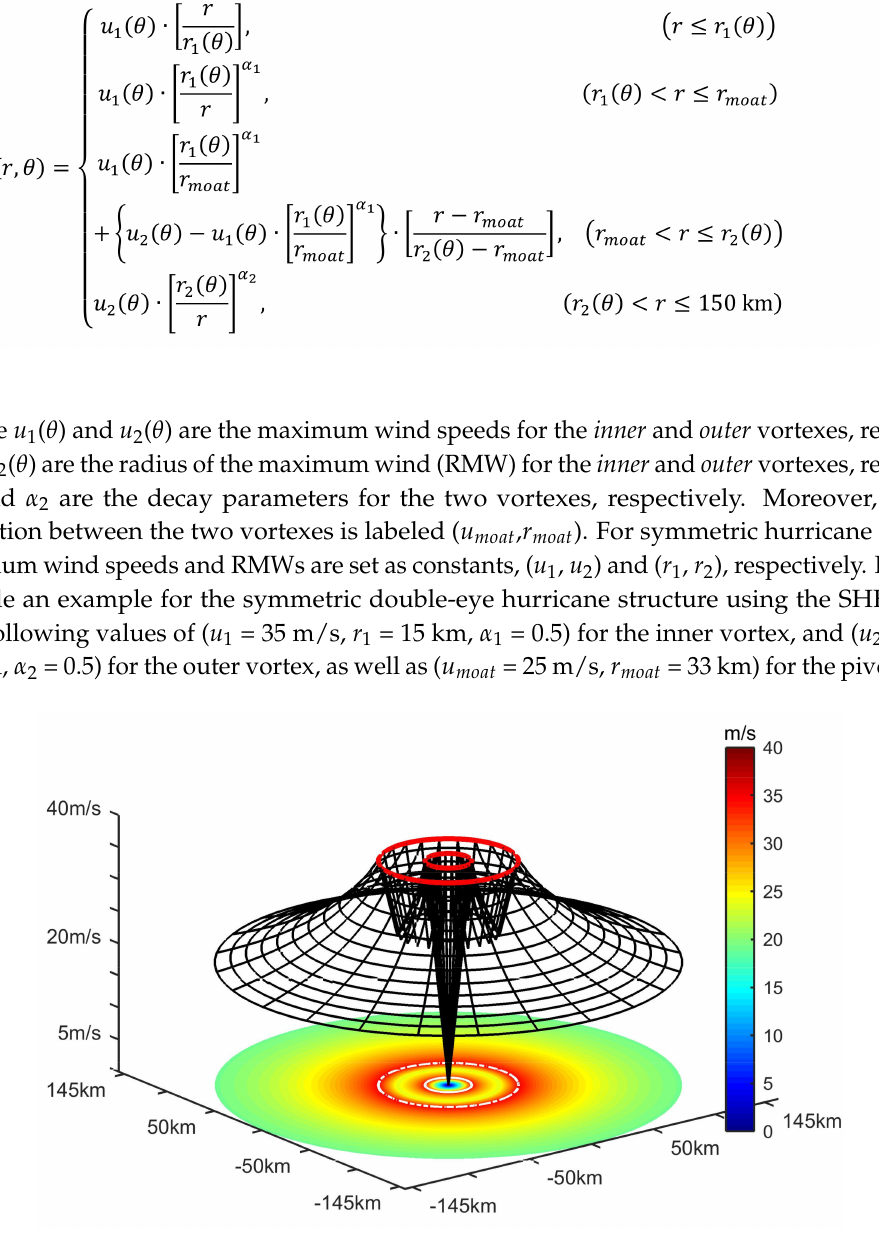
Figure 3. An example of the SHEW symmetric double-eye hurricane structure. The maxima wind speeds for two eyes are both 35 m/s, the RMW for the inner core is 15 km and for the secondary core is 45 km, and the two decay parameters are both